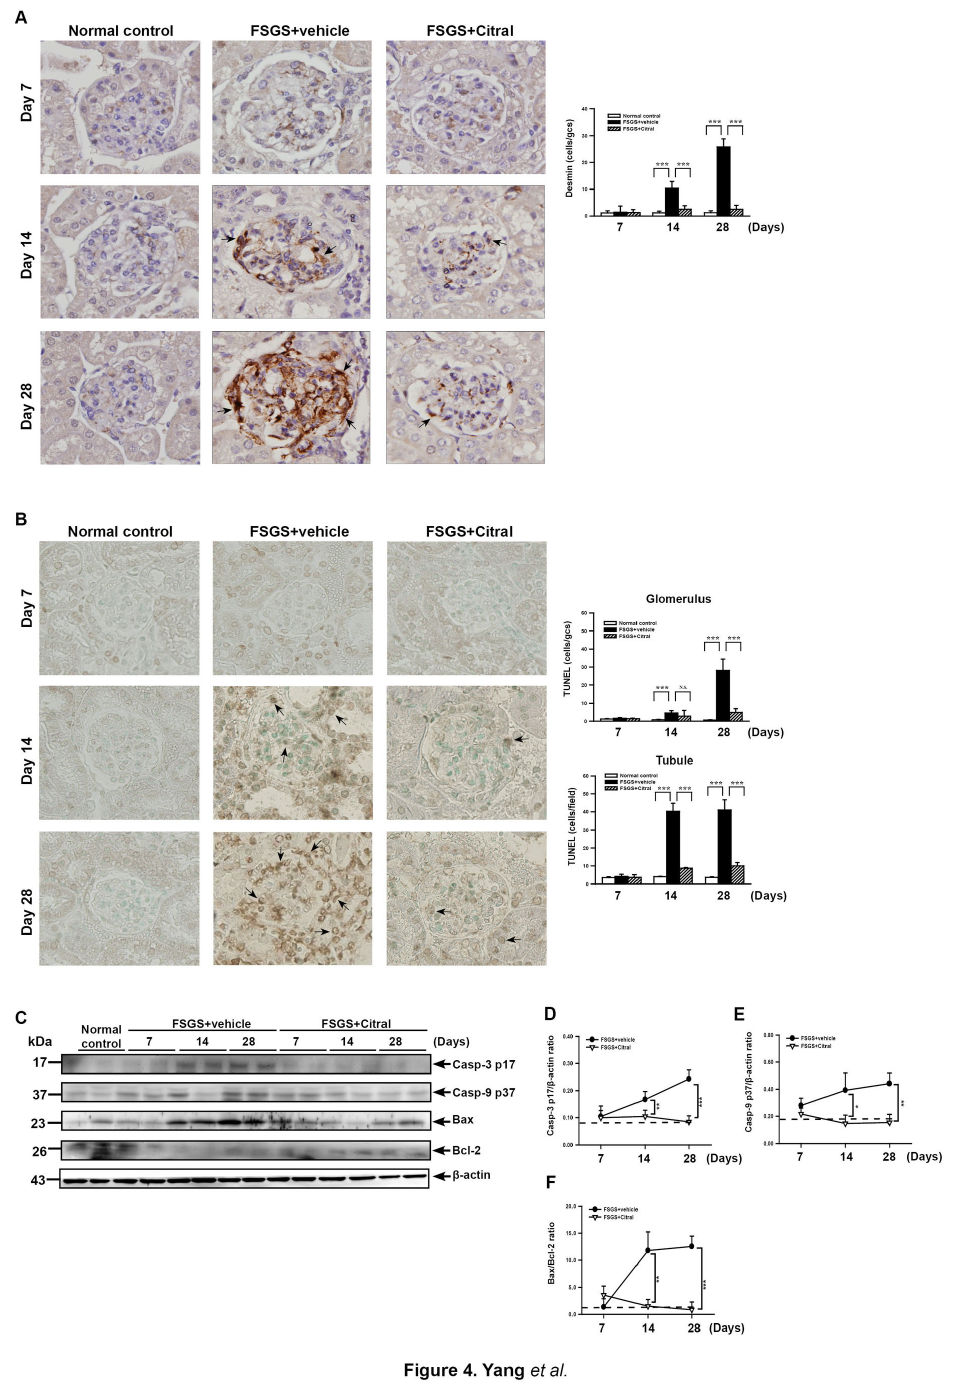
Figure 4. Podocyte injury and renal apoptosis in the glomerulus and tubule. (A) Podocyte injury detected in glomeruli by immunohistochemical staining for desmin. The black arrows indicate podocytes. Original magnification, 400×. Scoring of desmin expression in renal tissue is shown on the right. (B) TUNEL staining in renal tissues at day 7, 14, and 28. Original magnification, 400×. The arrows indicate positively stained cells. The scoring is shown on the right. (C) Representative Western blot for the active forms of caspase-3, caspase-9, Bax and Bcl-2, with β-actin as the internal control. (D-F) Active caspase-3/β-actin ratio (D), active caspase-9/β-actin ratio (E), and Bax/Bcl-2 ratio (F). In the histograms, the data are the mean±SEM for seven mice per group. * p < 0.05, ** p < 0.01, *** p < 0.005. doi: 10.1371/journal.pone.0074871.g004 PLOS ONE |